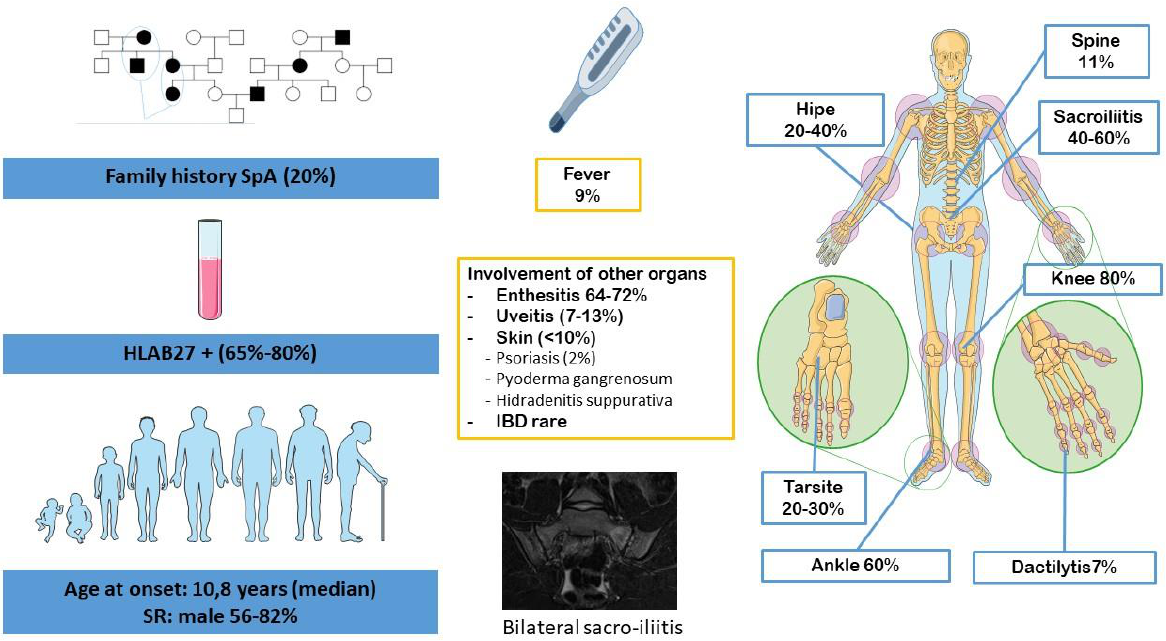
Figure 2. Clinical features of JSpA, specifically the ERA form of the JIA classification according to Edmonto et al. [14]. ERA: enthesitis-related arthritis; JIA: juvenile idiopathic arthritis; JSpA: juvenile spondyloarthritis